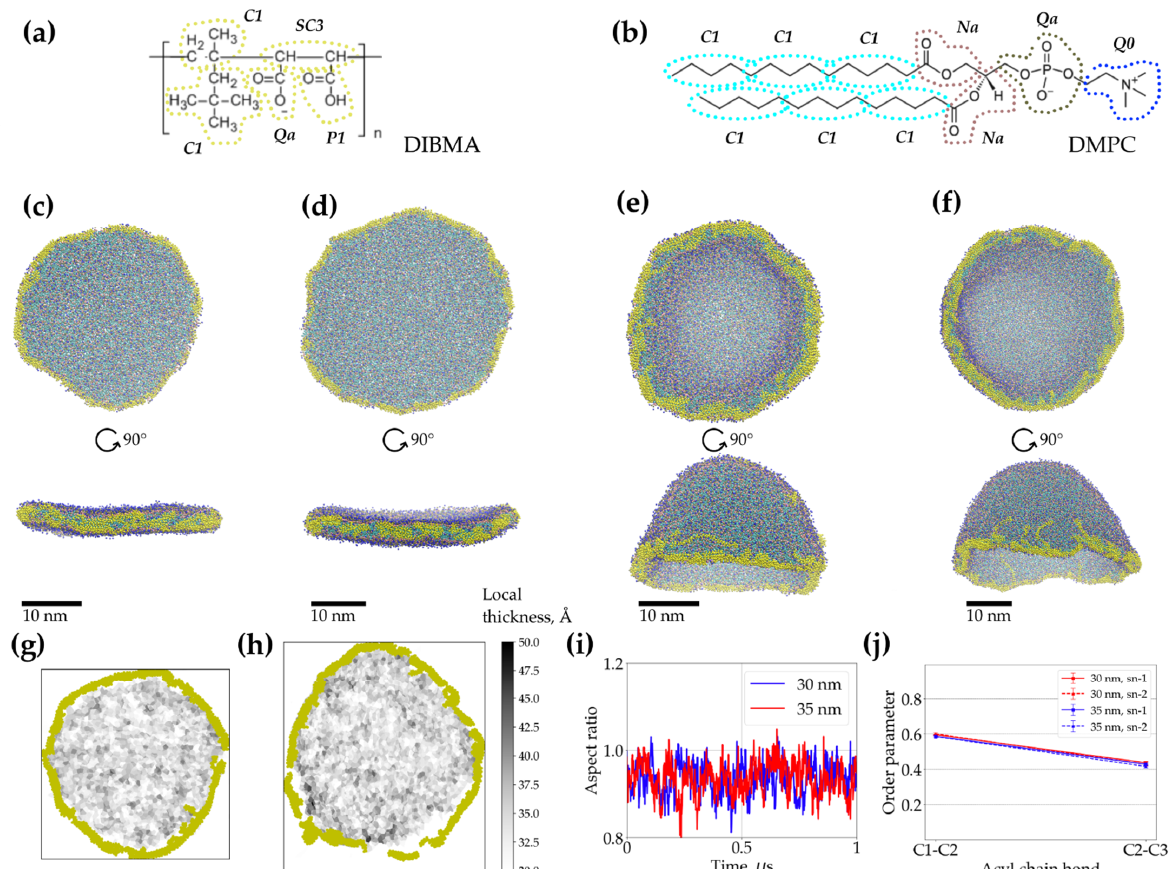
Figure 6. Coarse-grained (CG) molecular dynamics (MD) simulations of DIBMALPs of different diameter. The structural formulae of DIBMA copolymers ( a ) and DMPC lipids ( b ) used in this work. Periodically repeating chemical components of DIBMA polymers are enclosed in brackets and are marked with n. The mapping of all-atom structures to CG MARTINI models is shown with the dotted contours captioned with the corresponding MARTINI CG particle types. The colors of CG particles correspond to those in panels ( c – f ). Final structures of 30 nm ( c ), 35 nm ( d ), 40 nm ( e ) and 50 nm ( f ) DIBMALPs after 1-microsecond-long unconstrained MD simulations. Local thickness of 30 nm ( g ) and 35 nm ( h ) DIBMALPs. Ratio of disc dimensions along the first two principal axes of the 30 nm and 35 nm DIBMALP as a function of the simulation time ( i ). Order parameters of the DMPC acyl chains in 30 nm and 35 nm DIBMALPs ( j ).